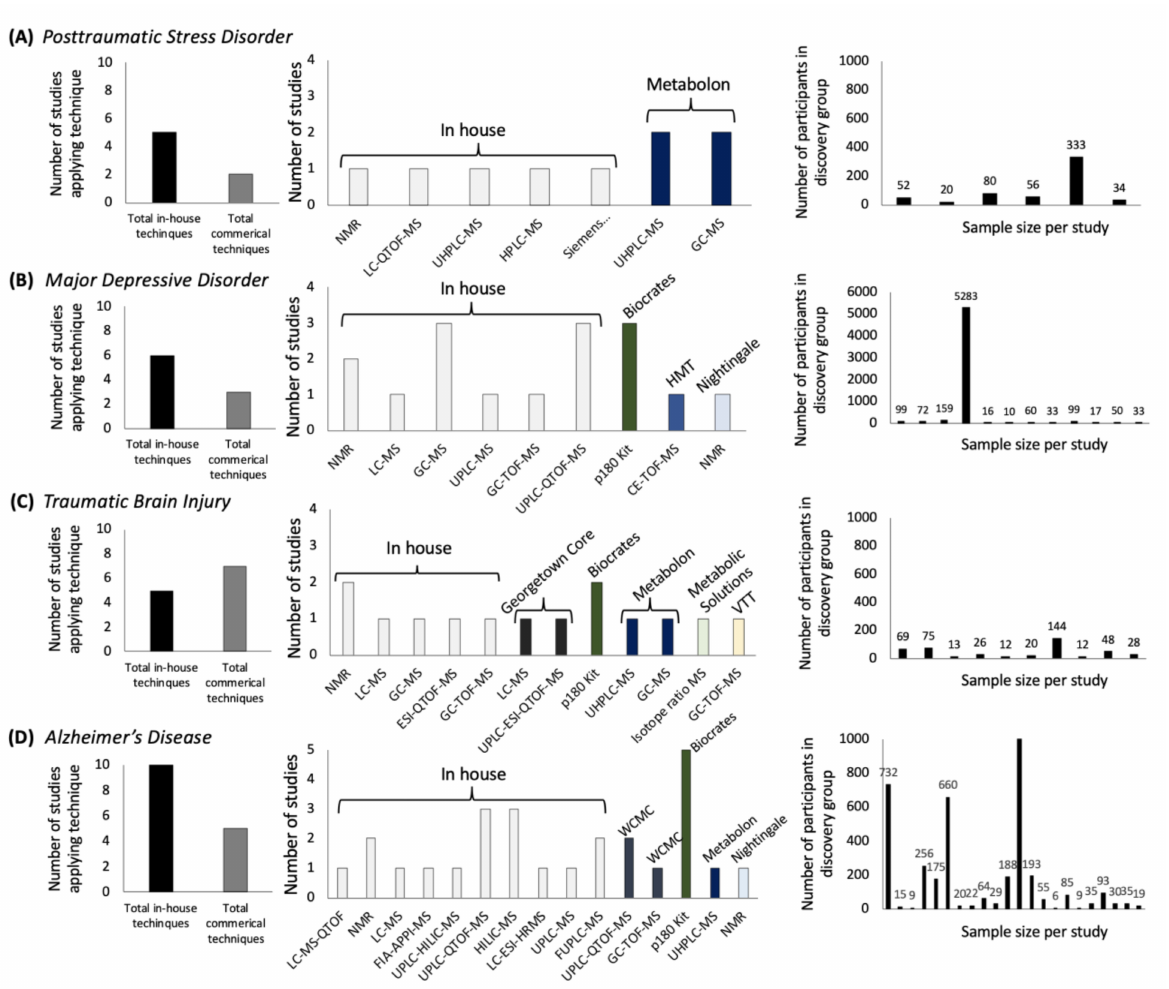
Figure 1. Metabolomics techniques and samples sizes in psychiatric research between 2015 and 2020 for four psychiatric conditions: ( A ) posttraumatic stress disorder, ( B ) major depressive disorder, ( C ) traumatic brain injury, and ( D ) Alzheimer’s